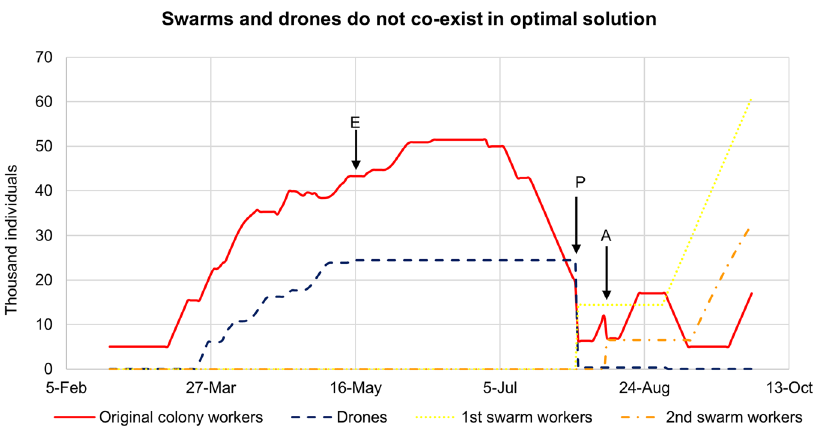
Figure 1. Queen and drone production do not co-occur in optimal solution. The dashed line shows the optimal number of drones and the solid line shows the optimal number of workers present in the colony on each day under model scenario 1. Under the assumption that other colonies in the population produce queens at an empirically estimated time 19 regardless of whether it is optimal, we find the optimal swarm date for the focal colony to be the end of July. In this model scenario, the optimal behavior is for the colony to produce all drones between April and July and evict all drones before the colony swarms at the end of July. The dotted line shows the number of workers in the prime swarm on each day; the dash-dot line shows the number of workers in the afterswarm on each day in the optimal solution. The letters P and A indicate when the prime swarm and afterswarm, respectively, are produced in the model. The letter E indicates the empirically measured swarm date in mid-May 19 , much earlier than predicted by the